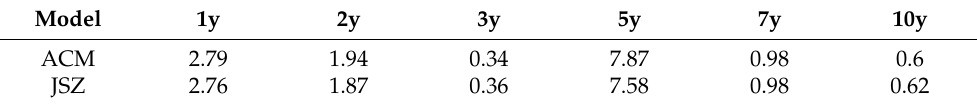
Table 2. Model fit (RMSE).